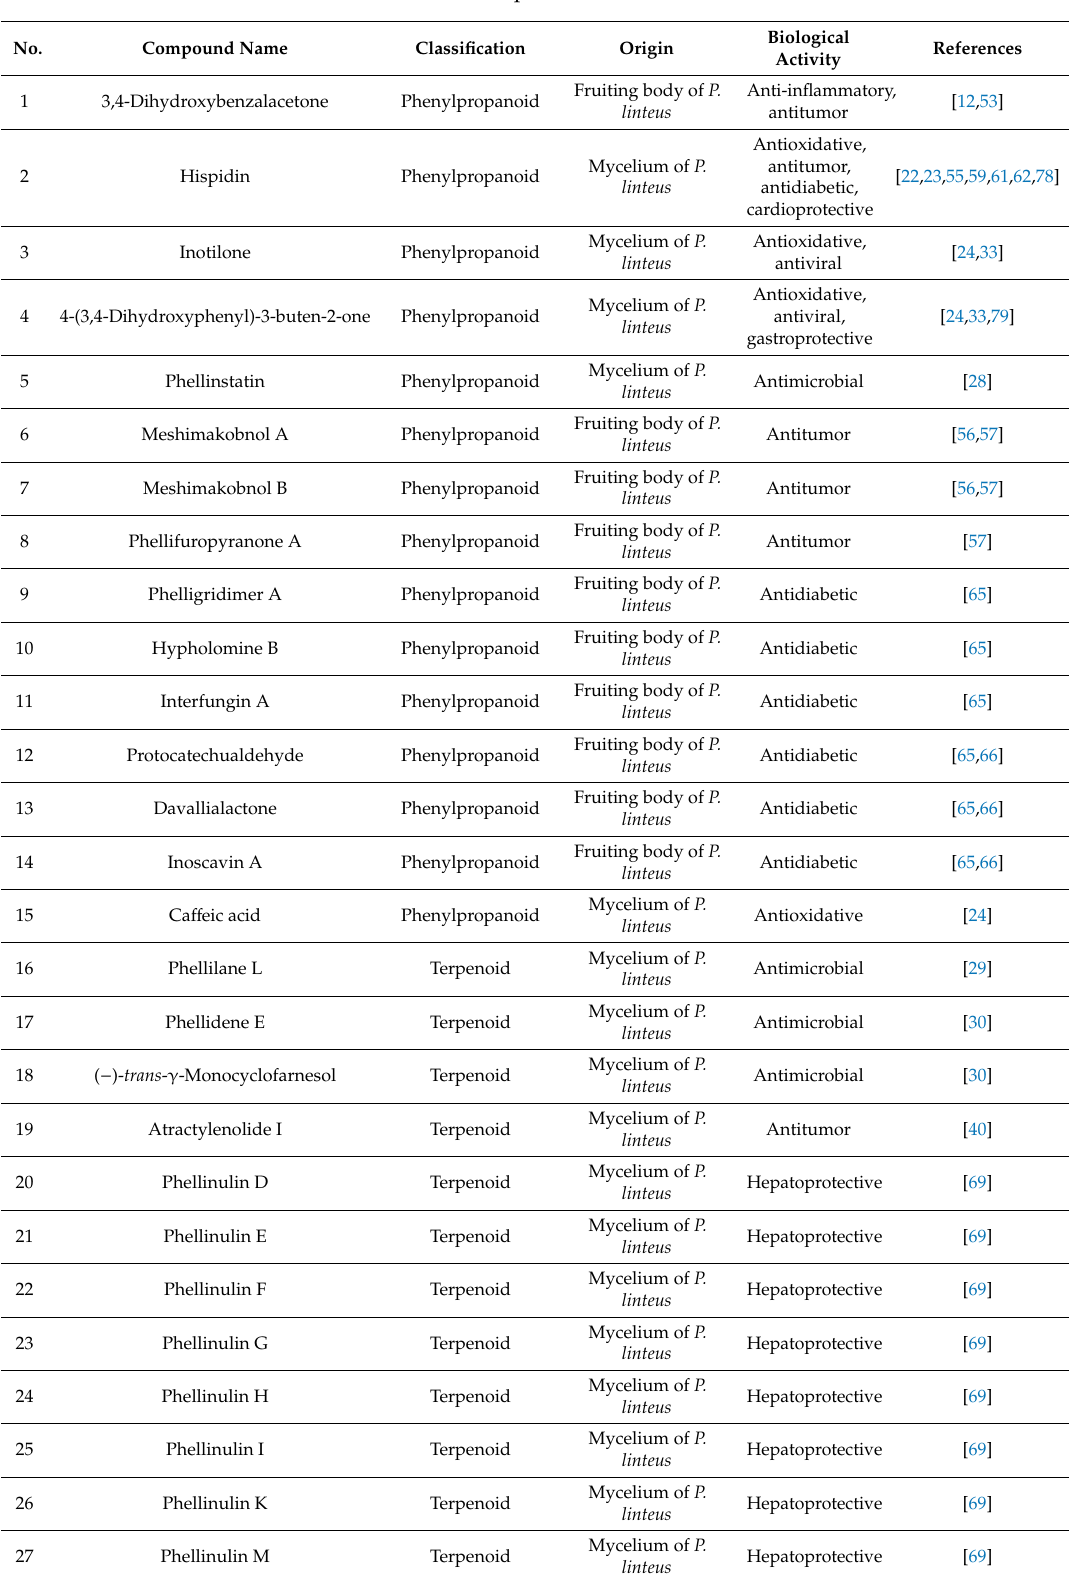
Table 1. The bioactive components isolated from P. linteus